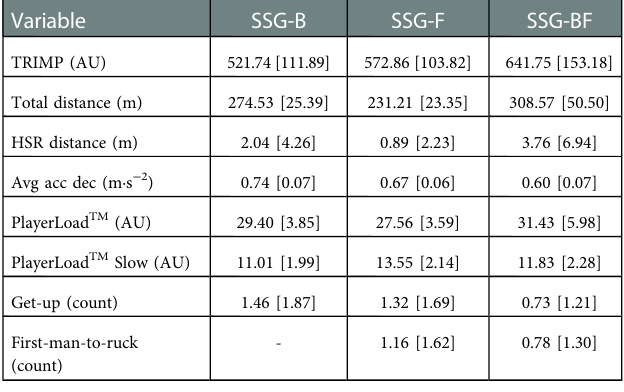
TABLE 4 Descriptive statistics (mean [standard deviation]) for the internal and external load characteristics for the three small-sided game designs. Variable